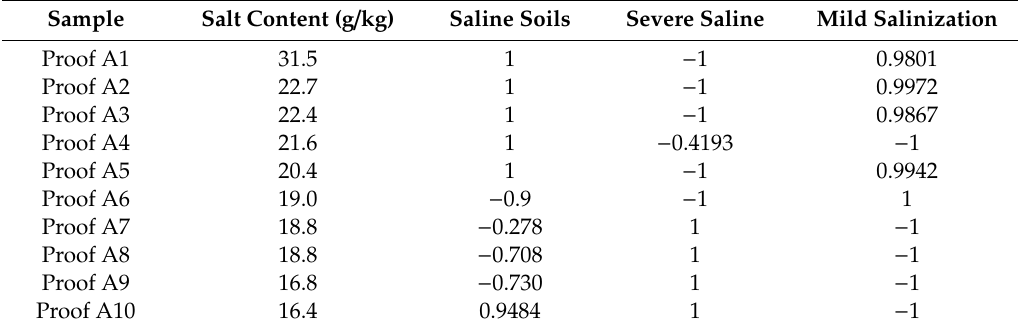
Table 5. Comparison of extension classification correlation value and salt content in Area A’s verification set.